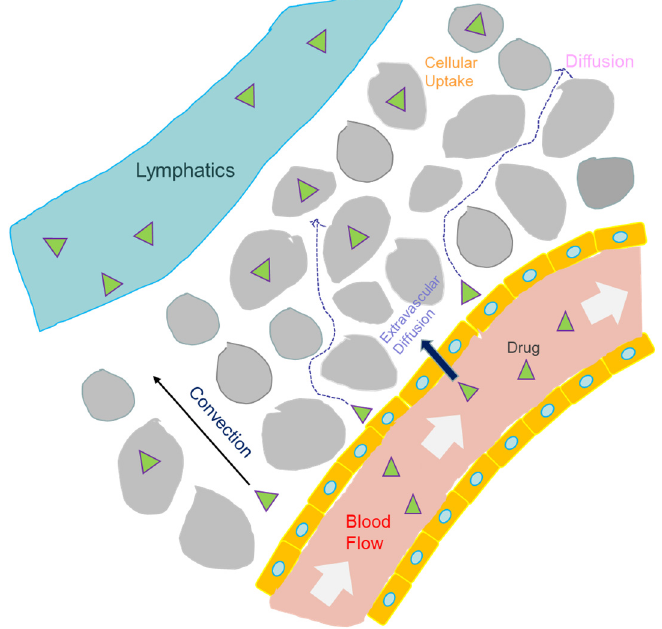
Figure 8. Transport and reaction kinetics involved in drug delivery in circulation, from blood vessel to lymphatics, which are detectable with FRAP